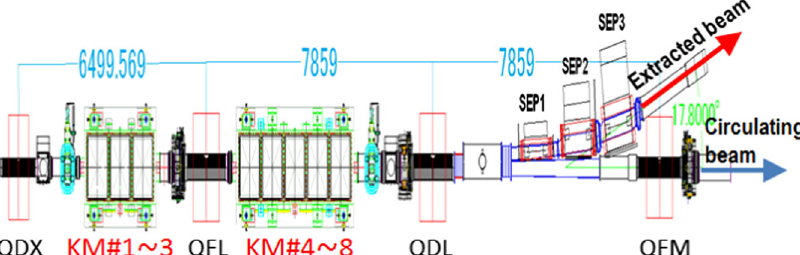
FIG. 2. Layout of the RCS extraction straight section. A total of eight pulsed kicker magnets is used for the beam extraction. The first three are placed upstream of a horizontally focusing quadrupole magnet (QFL), while the other five are placed downstream of the QFL. The transverse impedance of the kicker magnets is the dominant source of beam instability in the RCS.